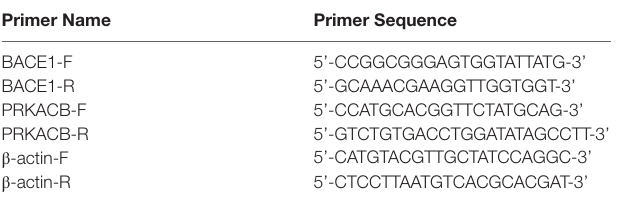
TABLE 2 | PCR primer sequences.